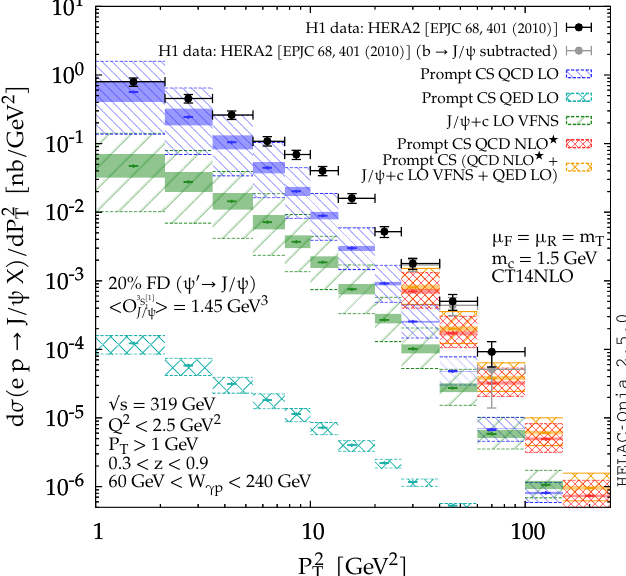
Figure 1: Comparison between H1 data [ 7 ] (black: inclusive yield; grey: estimated prompt yield) and various CS contributions: LO (blue), NLO (cid:63) (red), LO VNFS J /ψ + c (green), LO QED (light blue) and their combination (orange). The solid bands in- dicate the mass uncertainty while the patterns display the scale uncertainty. Figure taken from Ref. [ 1 ]